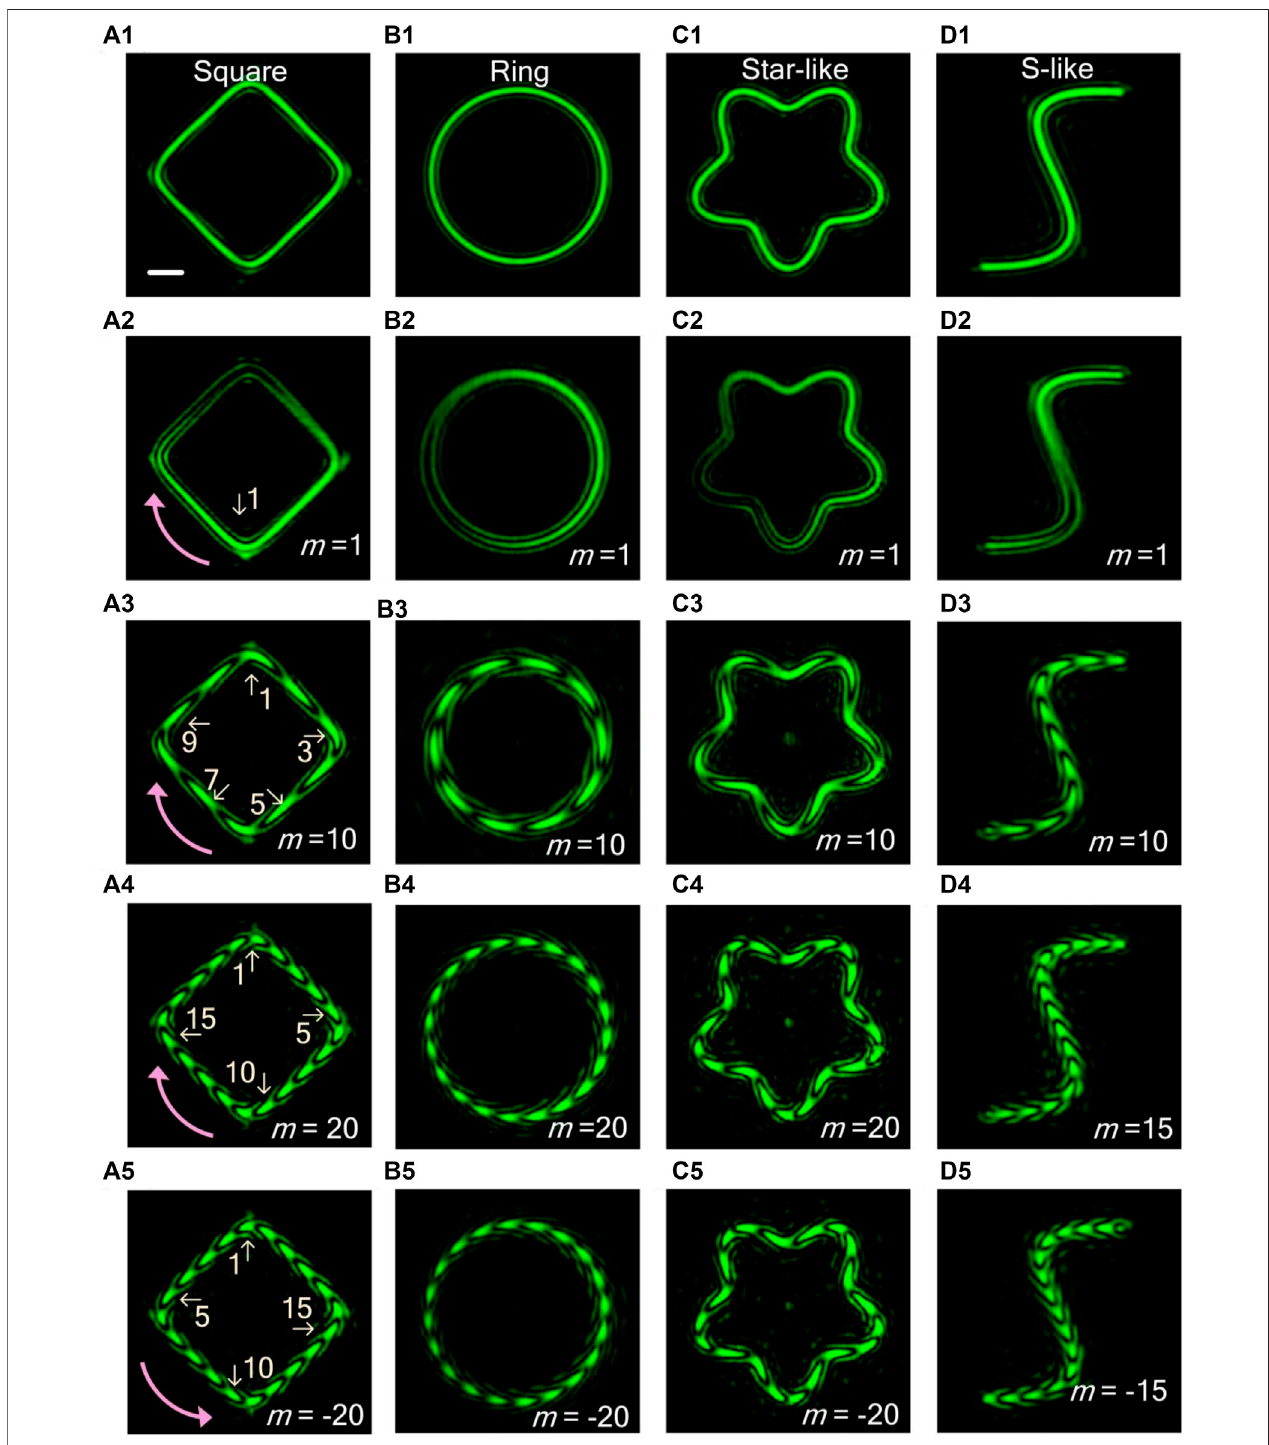
FIGURE 2 | Experimentalresults fordeterminingtheintegralPGPof2DPBs.The (A1 – D1) inthe fi gurerespectivelyshowstheintensitydistributionofsquare-shaped beam, ring-shaped beam, star-like beam, and S-like beam. (A2 – D5) are the interference patterns of PBs with m = 1, 10, 20, − 20, R 0 = 300 μ m, except for (D4) and (D5) , which are the interference patterns of the S-like beam with m = ±15. Scale bar: 100 μ m.